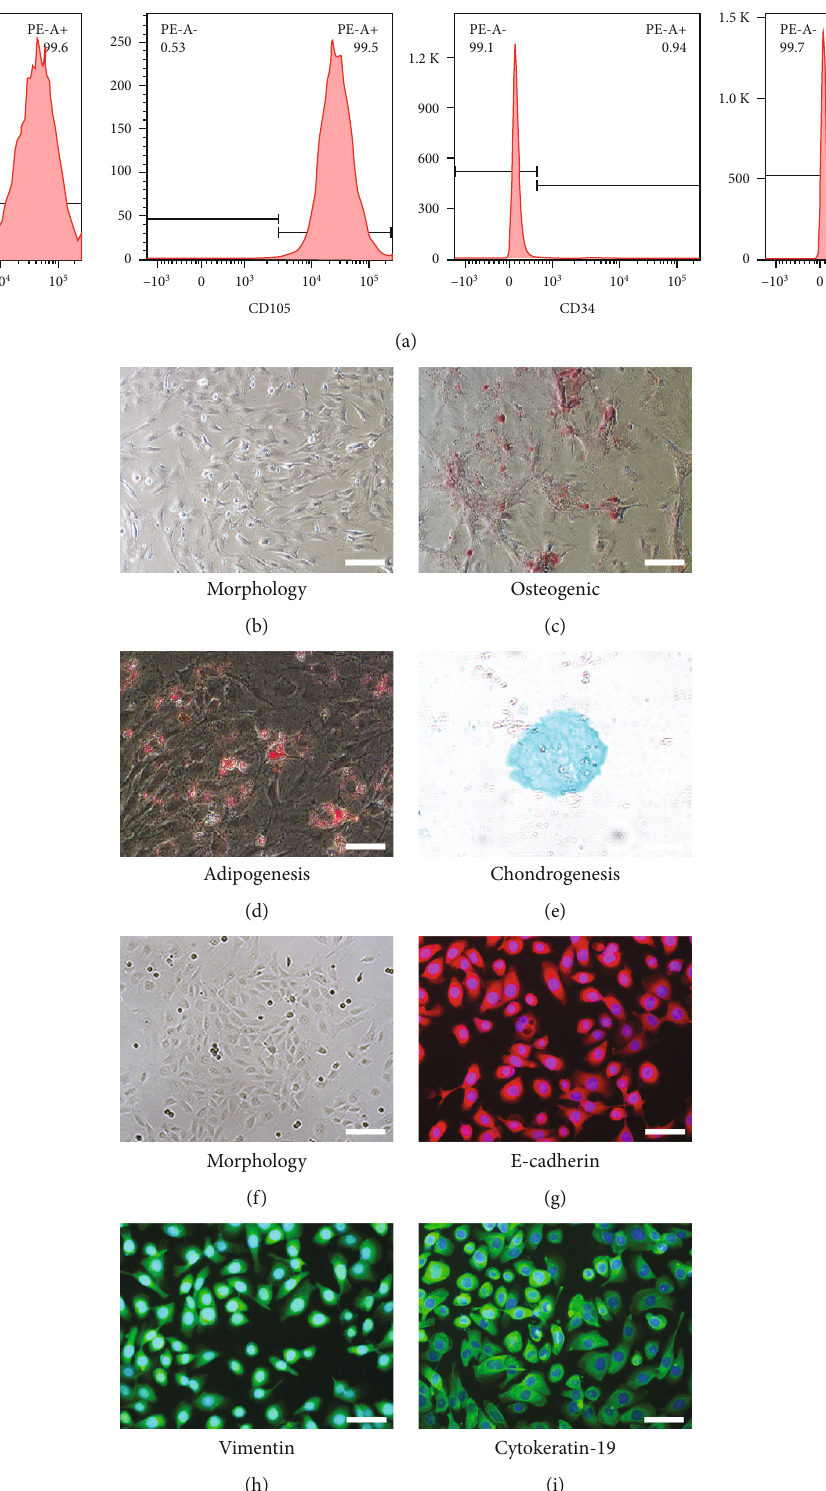
Figure 1: Characterization of ADSC and RPCM. (a) Flow cytometry for detection of ADSC surface markers, including CD90, CD105, CD34, and CD45. (b) Morphology of ADSC. (c) Osteogenic. (d) Adipogenic. (e) Chondrogenesis di ff erentiation potential of ADSC. (f) The phenotype of rat peritoneal mesothelial cells (RPMCs) in culture. Immuno fl uorescence staining of RPMC. Mesothelial cells with (g) E-cadherin, (h) vimentin, and (i) cytokeratin-19. Original magni fi cation: ×